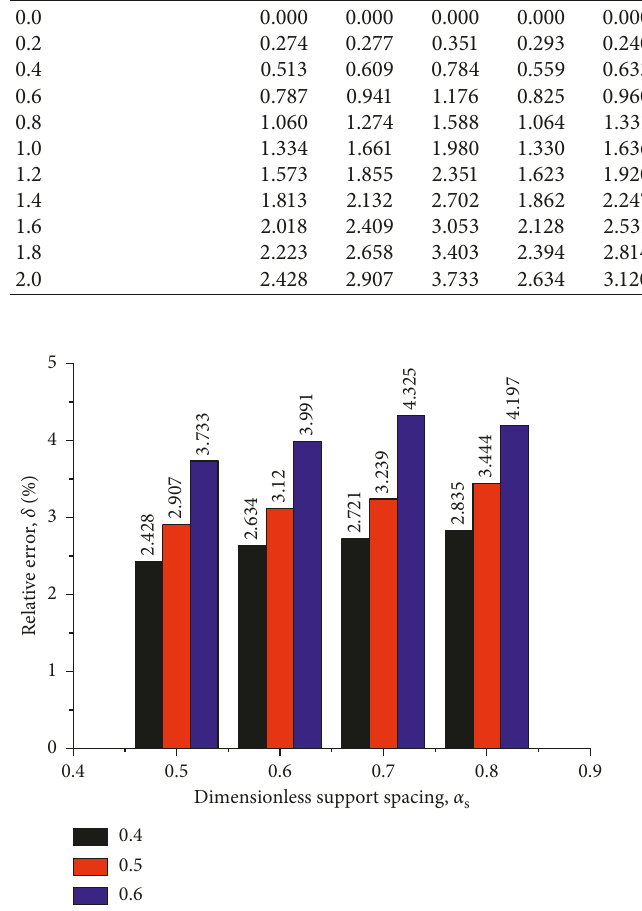
Table 2: Errors of dimensionless stress intensity factors of the NSCB specimens due to different widths of prefabricated cracks. Crack width, 2 b (mm) 0.2